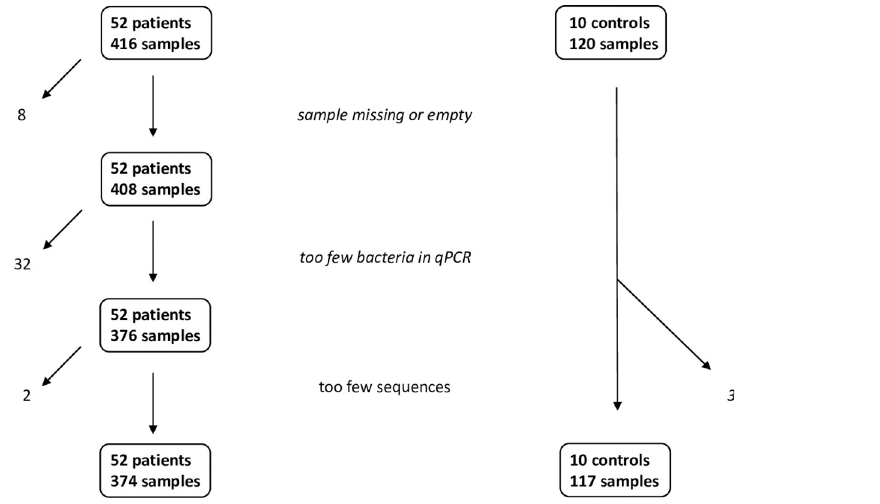
Fig 1. Flowchart of samples from 52 patients and 10